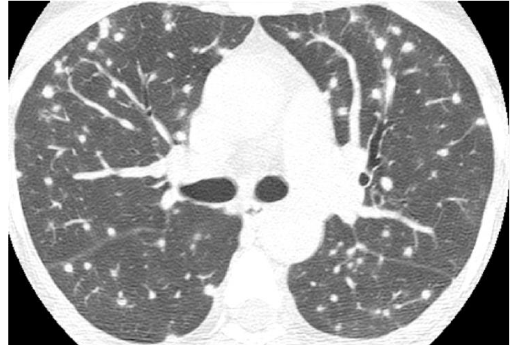
Figure 2. Axial CT image in a patient with histoplasmosis shows numerous bilateral and randomly distributed solid nodules, some of them with peripheral ground-glass halos.